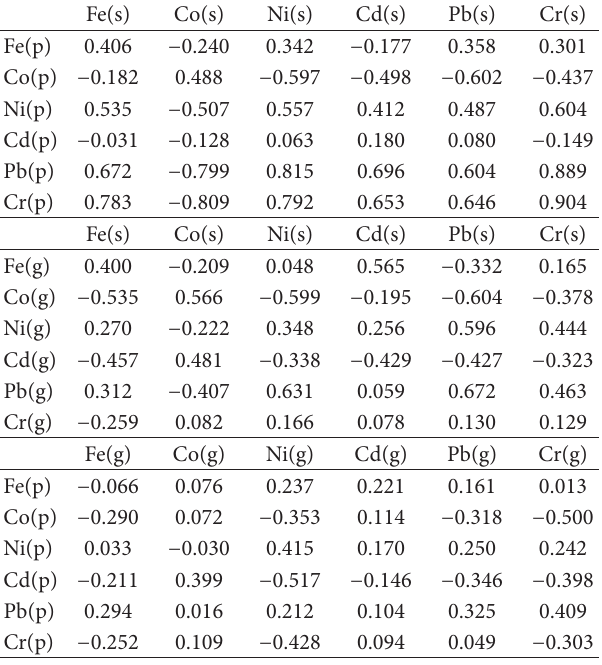
T 5: Correlation coefficient matrix for metal levels in